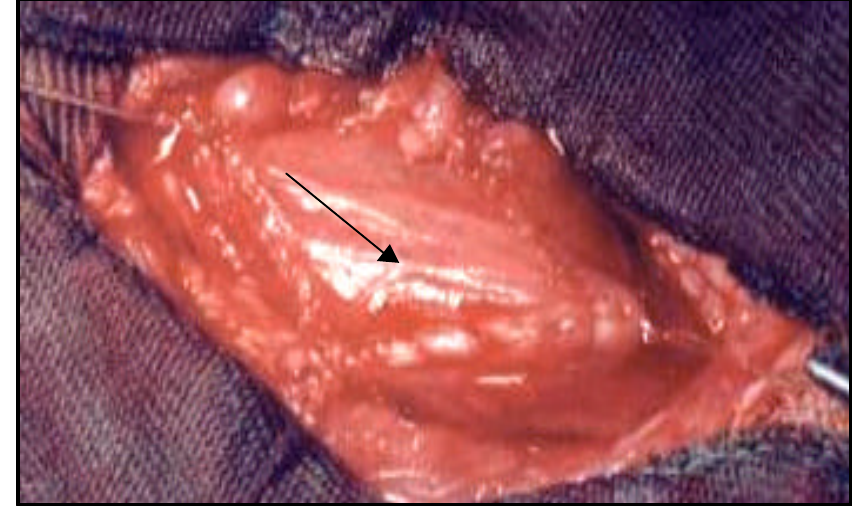
FIGURA 3 - Correção da estenose: implante do enxerto SID